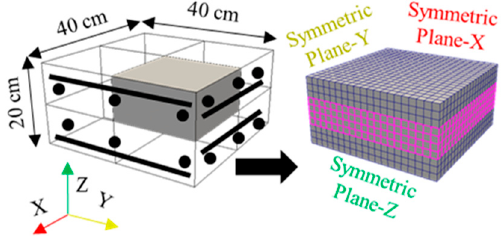
Figure 12. FE model of one fourth of the specimen.